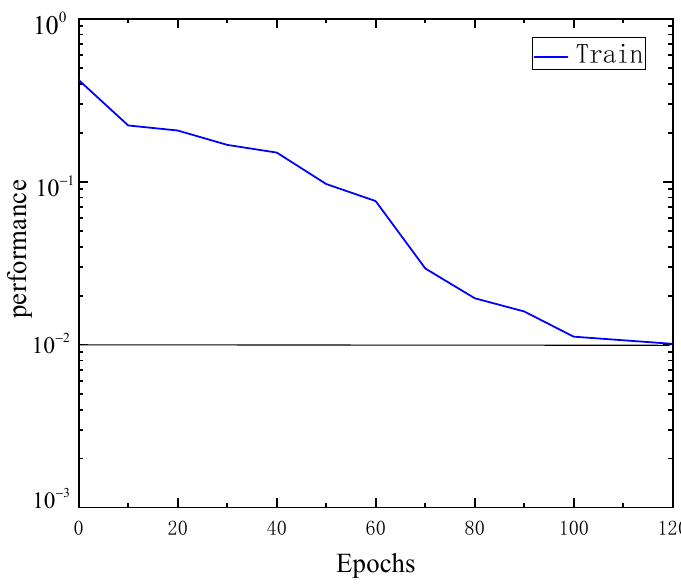
Figure 5. RBF neural network error curve.